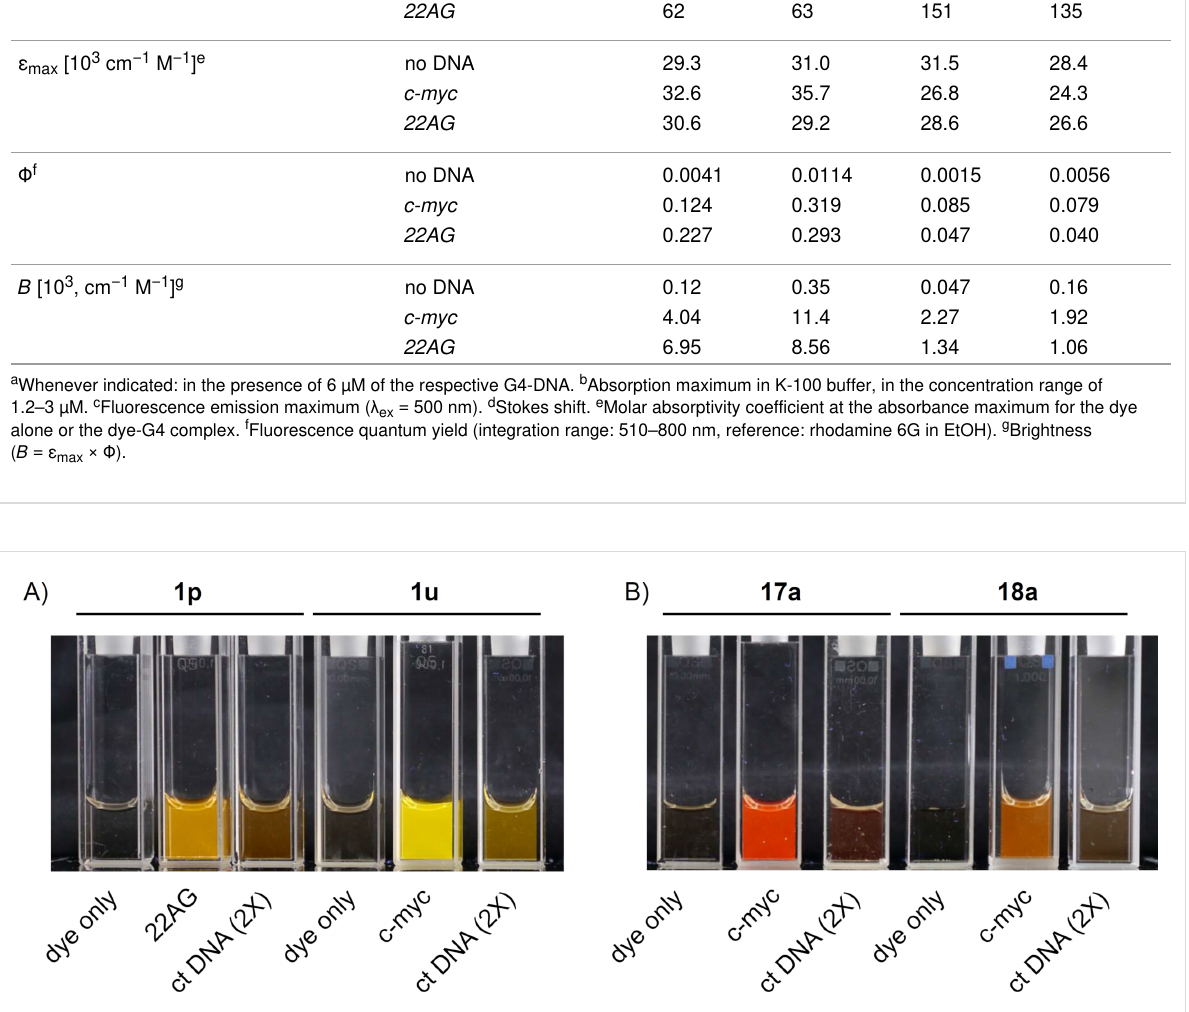
Table 3: Optical parameters (absorption and emission maxima, Stokes shift, molar absorptivity coefficient at the absorption maximum, fluorescence quantum yield and brightness) of dyes 1p , 1u , 17a and 18a in the absence of DNA or in the presence of G4-DNA structures ( c-myc and 22AG ). Properties